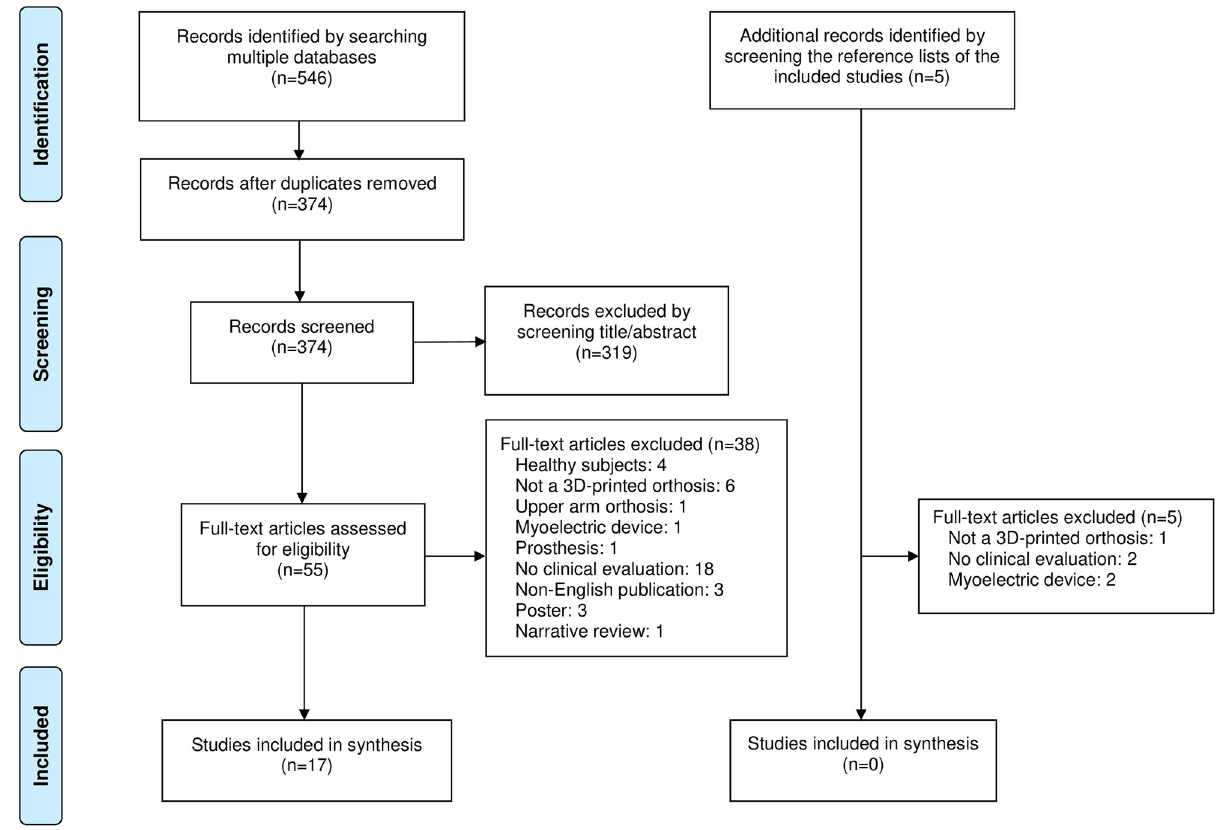
Fig 1. PRISMA-ScR flow